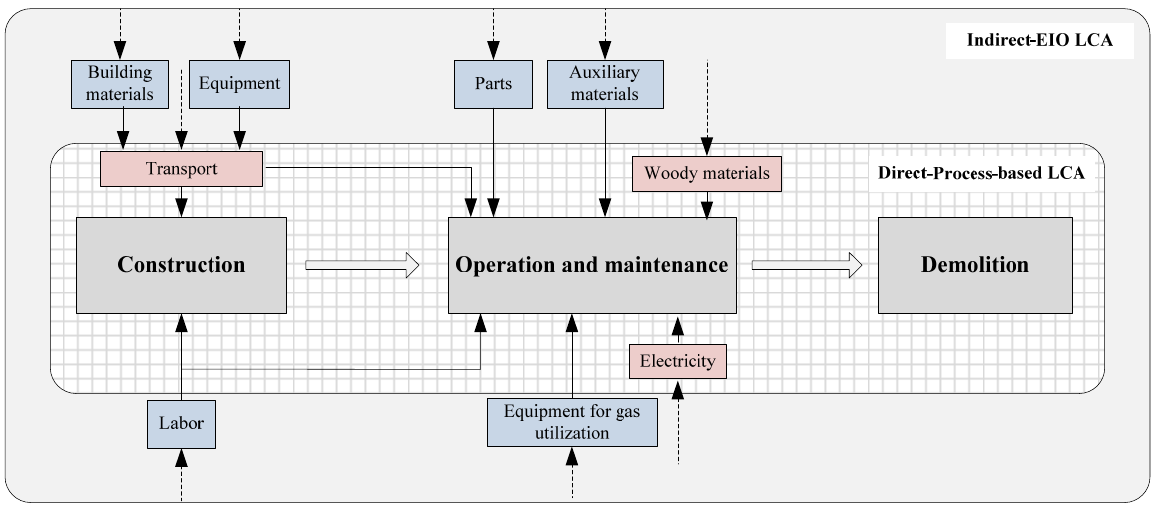
Figure 2. Hybrid LCA boundary of the village-level biomass gasification station discussed in this